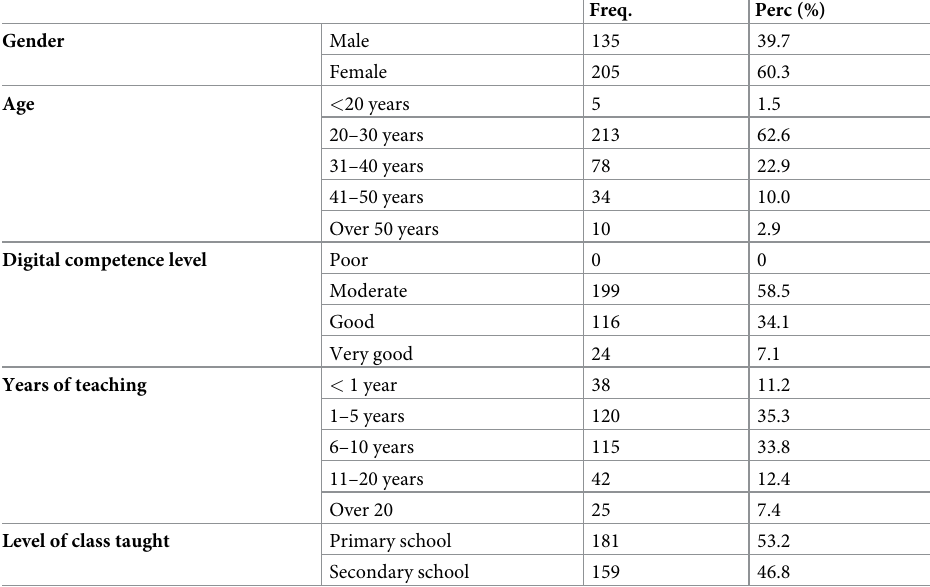
Table 2. Teacher sample statistics.